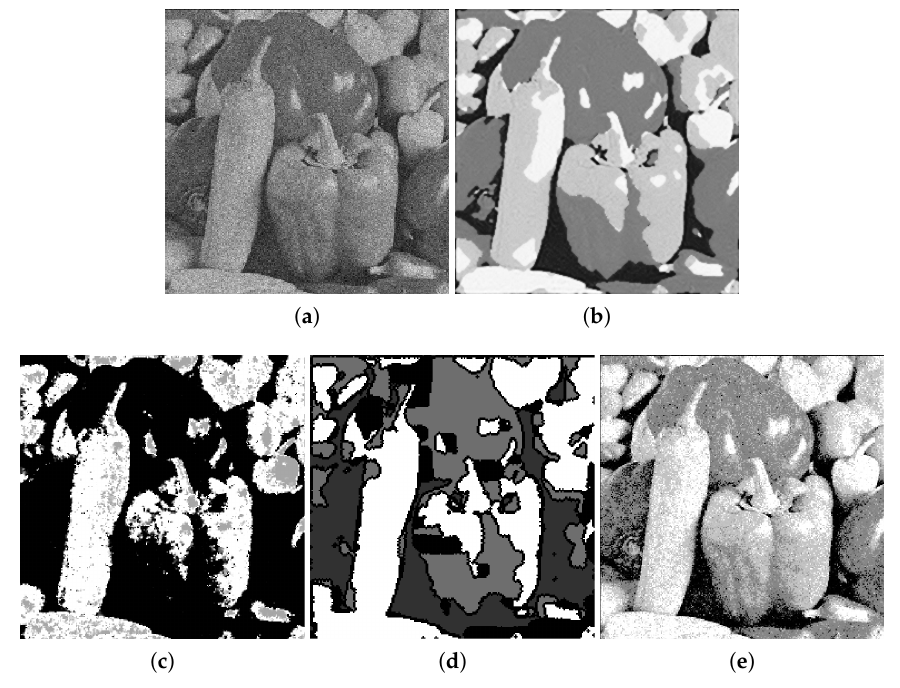
Figure 6. Compare the segmentation results of ( a ) the peppers image with added Gaussian noise (SNR = 15 dB) using ( b ) the proposed method, ( c ) graph cut, ( d ) Vese–Chan and ( e ) fuzzy segmentation